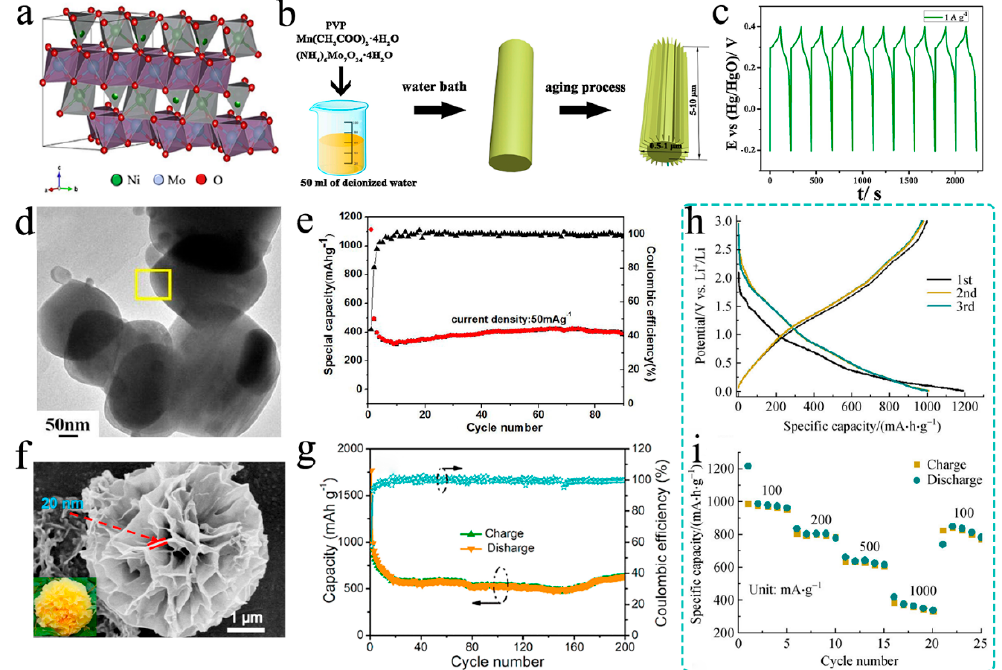
Figure 3. ( a ) Crystal structure of monoclinic NiMoO 4 illustrating the coordination relationship of NiO 6 and MoO 6 octahedra. Reproduced with permission. [45] Copyright 2018, Elsevier Ltd. ( b ) Schematic diagram illustrating the formation process of rod-like MnMoO 4 crystalline with two-dimensional nanoflakes. ( c ) GCD (galvanostatic charge–discharge) curves of the energy storage made from rod-like MnMoO 4 crystalline in last 10 cycles at 1A g − 1 . Reproduced with permission. [46] Copyright 2017, Elsevier Ltd. ( d ) SEM image of α -ZnMoO 4 . ( e ) Cycling performance of α -ZnMoO 4 . Reproduced with permission. [47] Copyright 2017, Elsevier B. V. ( f ) SEM image of Cu 3 Mo 2 O 9 . ( g ) Cycling performance and coulombic efficiency of Cu 3 Mo 2 O 9 at 0.1 A g − 1 . Reproduced with permission. [48] Copyright 2017, Elsevier B. V. ( h , i ) Discharge–charge voltage profiles and rate performance of Fe 2 Mo 3 O 8 hollow spheres. Reproduced with permission. [49] Copyright 2020, Higher Education Press.